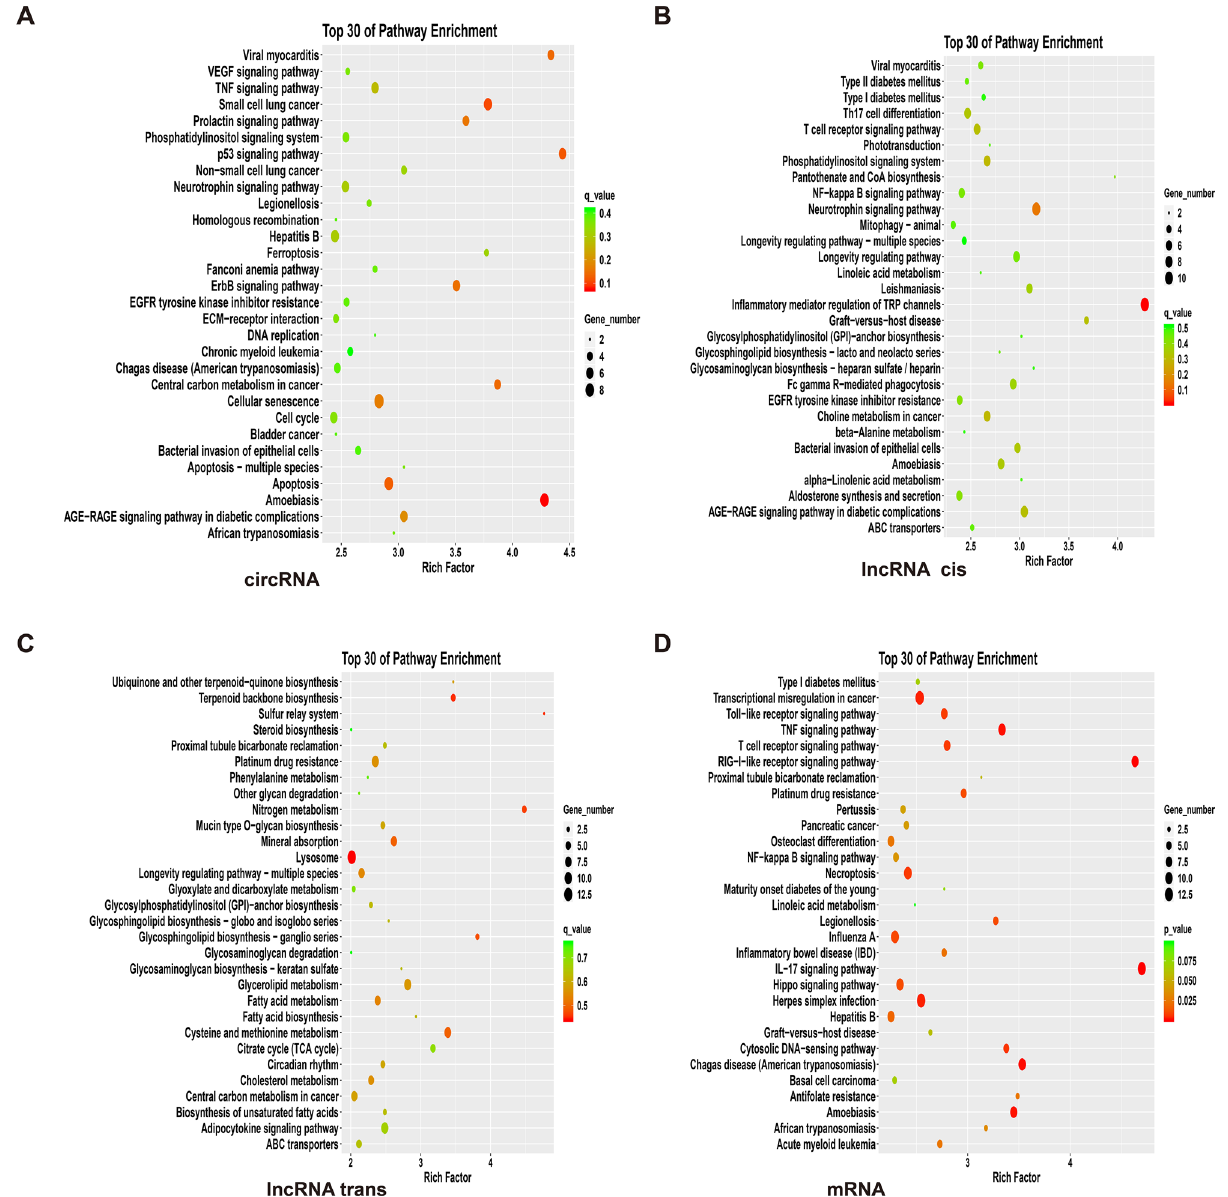
Figure 3. KEGG enrichment result. ( A ) circRNA; ( B ) lncRNA cis; ( C ) lncRNA trans; ( D ) mRNA. The selection standards include that the differential gene count dropped on certain term is not less than 2, and p value is smaller than 0.05. The term in the drawing is arranged in descending order of size according to the value of an enrich factor, and takes the first 30 results. Samples are from 3 recurrent COVID-19 patients and 3 healthy people. Data package is clusterProfiler, from R (version